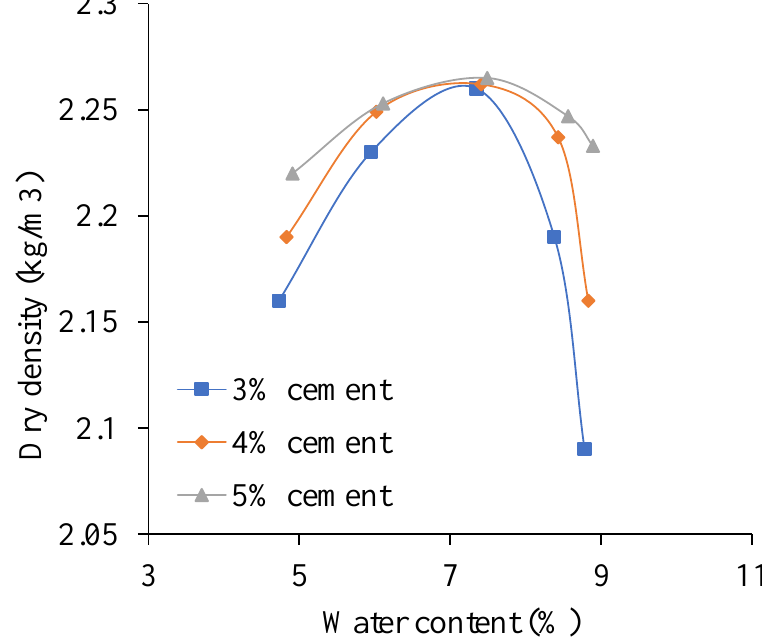
Figure 14. The relationship curves between water content and dry density.